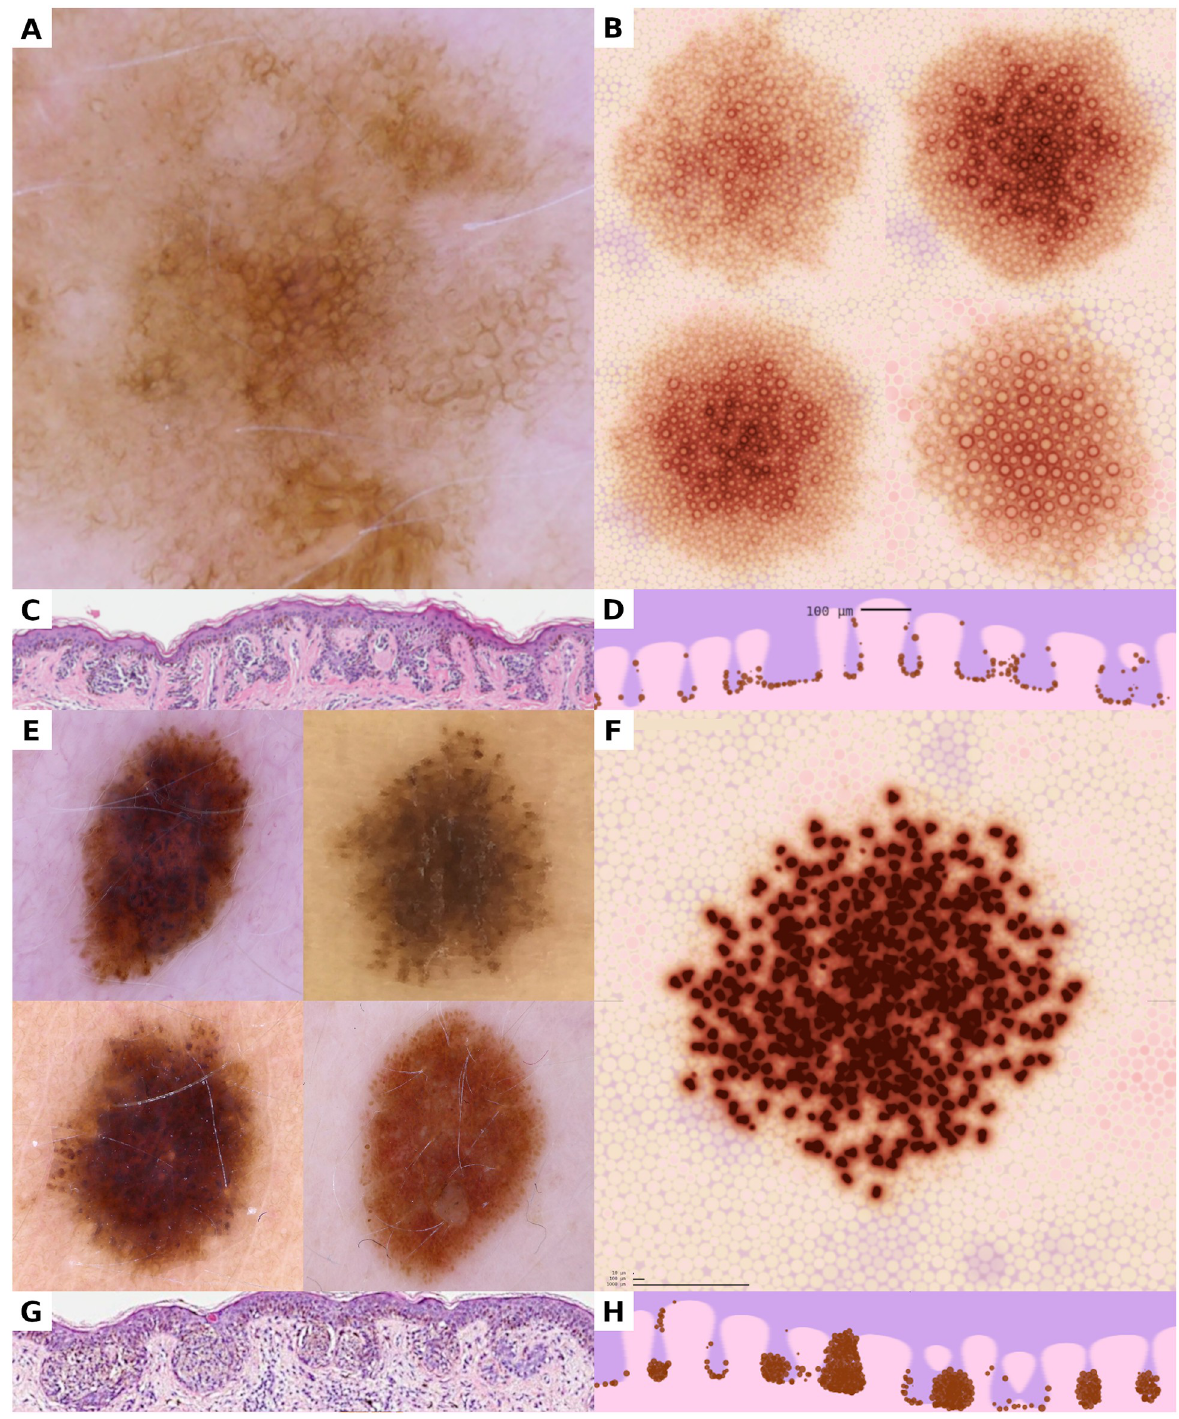
Fig 1. Juxtaposition of dermatoscopic and histopathologic images of real nevi and visualizations of simulated melanocyte populations. (A, B, C, D) A dermatoscopic photograph of a real nevus (A) and visual representations of corresponding simulated nevi (B) show that the reticular pattern can be reproduced in dynamic simulations. The preferential arrangement of melanocytes at the base of the rete ridges, as visible in histopathologic sections (C), can be reproduced in simulations and manifests in the visual representations (D). (E, F, G, H) Melanocytic nests appear as small brown globules in dermatoscopic images of globular nevi (E). The formation of nests in simulated populations yields the same globular pattern in visual representations (F). Vertical aspects of the dermo-epidermal junction with melanocytic nests is demonstrated in